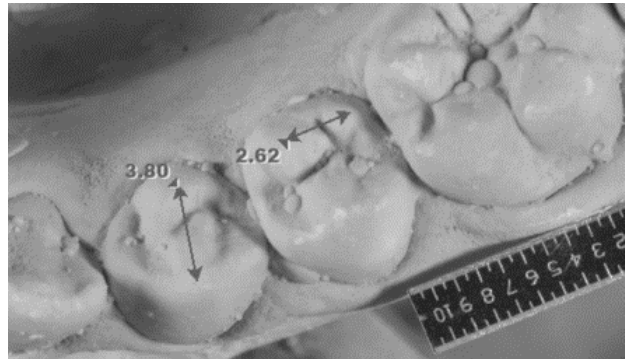
Figure 2. Intercuspal distance measurement on lower premolars.